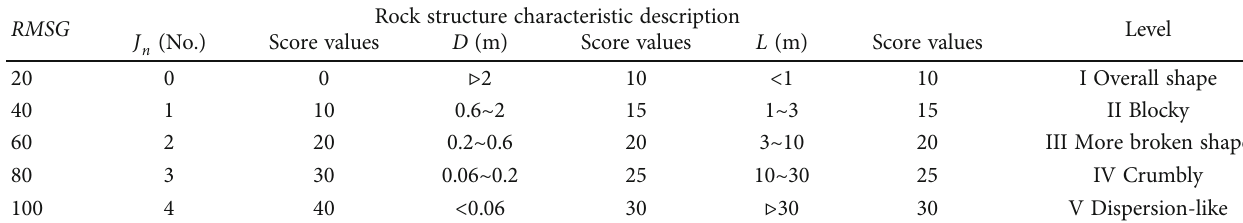
Table 4: RMSG values and characteristic description of rock structure.